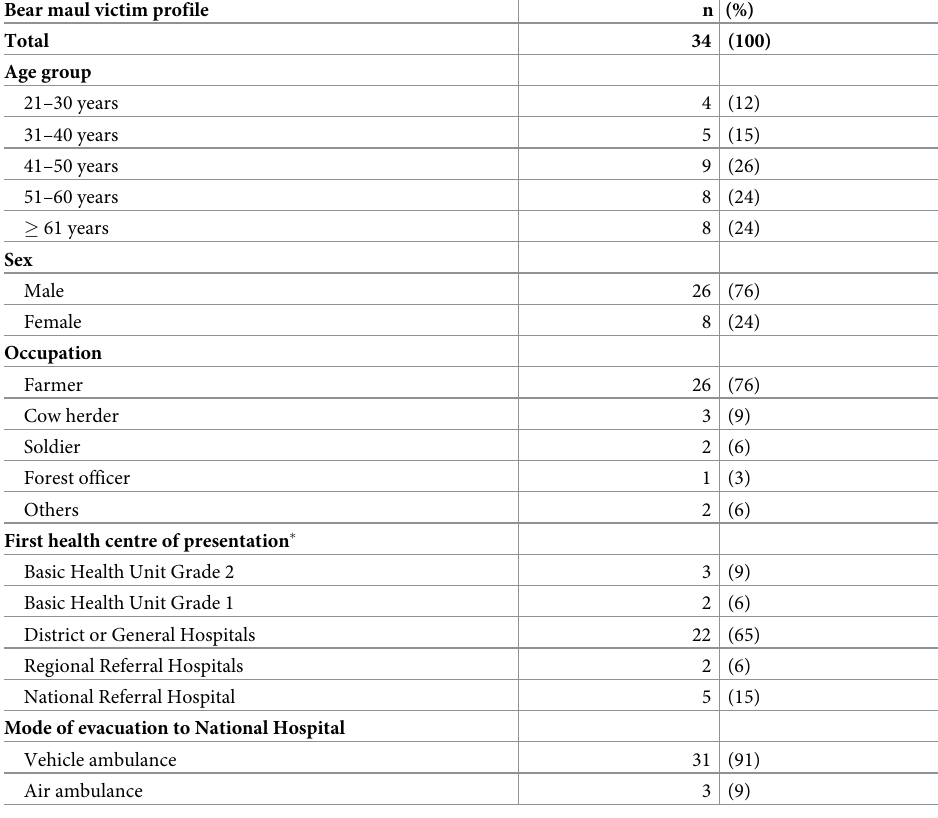
Table 1. The socio-demographic profile of victims of bear attacks who received care at the Jigme Dorji Wang- chuck National Referral Hospital, Bhutan from 2015 to